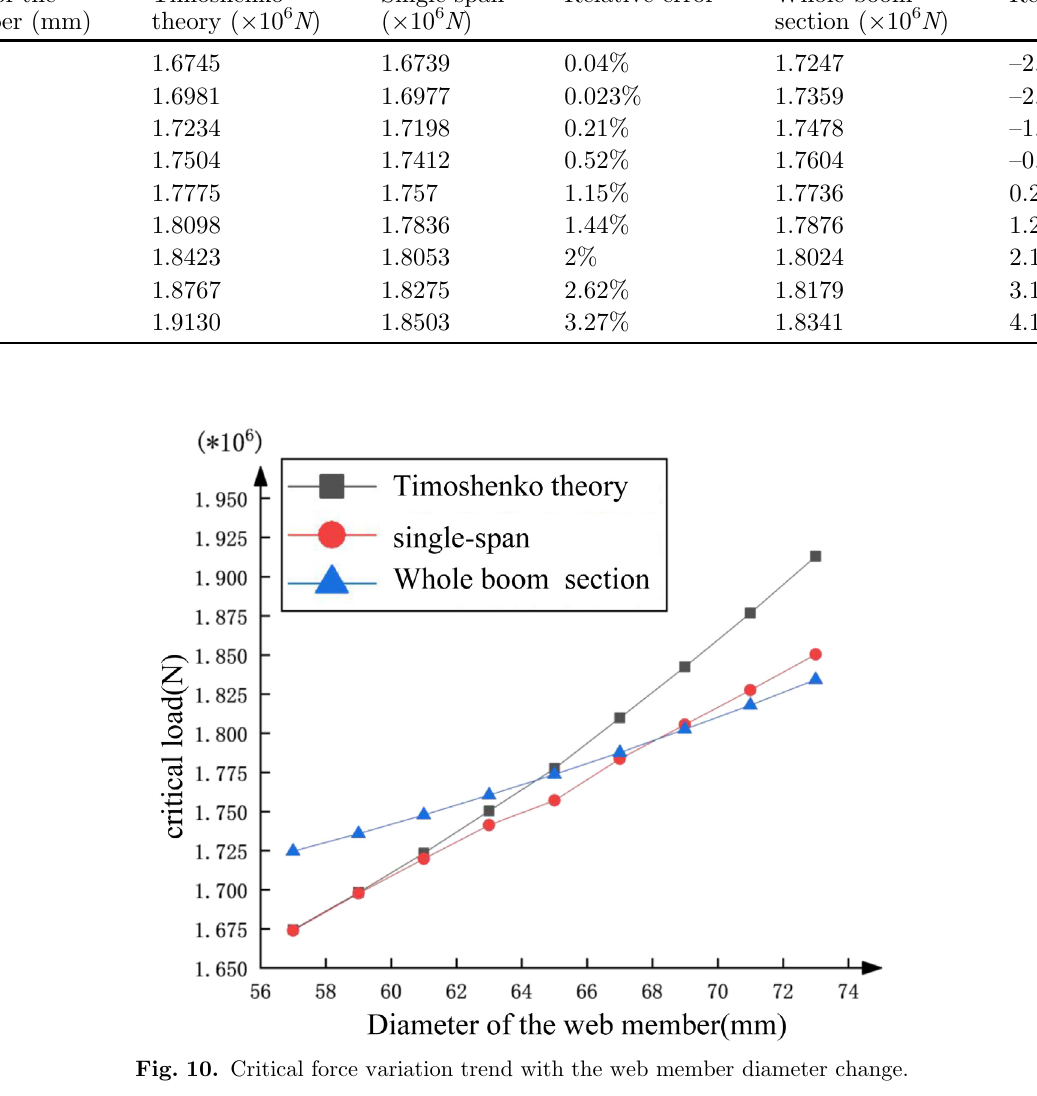
Table 6. Comparison under different web member sizes. Diameter of the